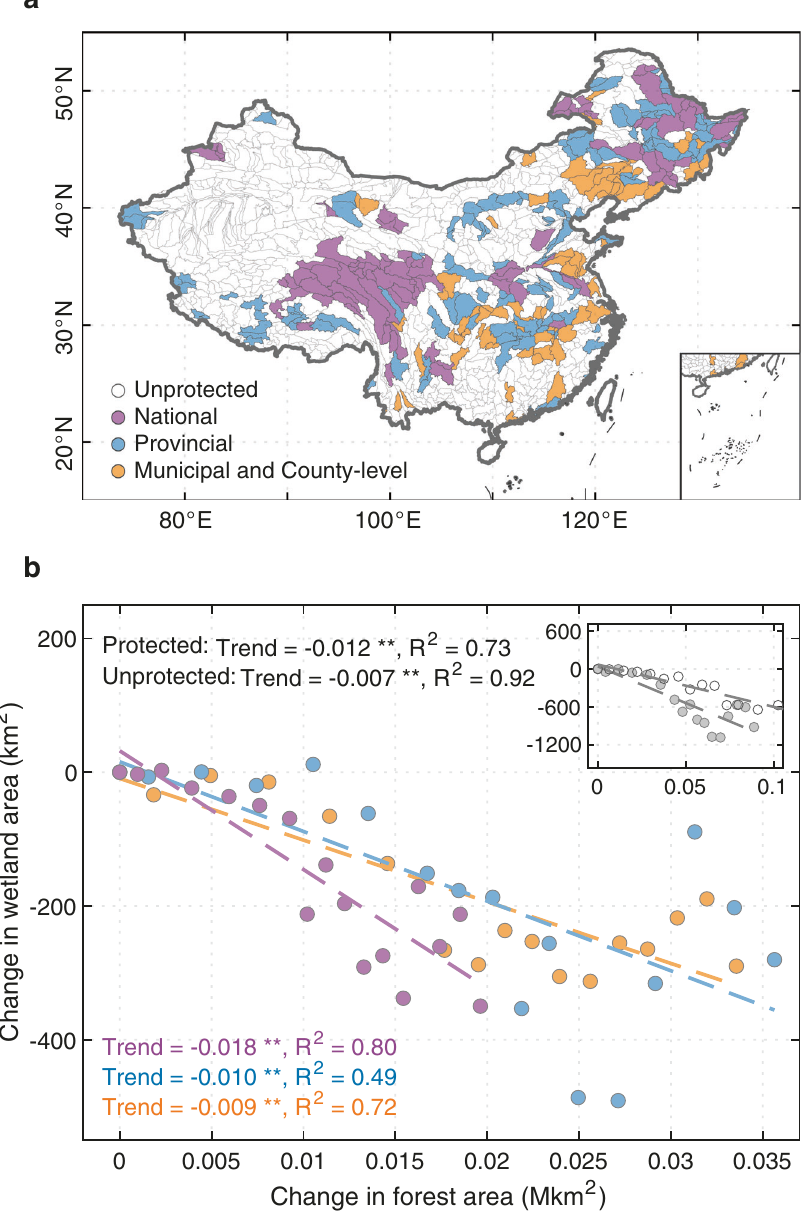
Fig. 4 Historical wetland change due to forest change across protected basins. a Spatial distributions of basins containing unprotected (transparent), national (purple), provincial (blue), and municipal and county-level (orange) wetland nature reserves. b Change in wetland area versus change in forest area across basins with different wetland conservation and all protected and unprotected basins (the inset) from 2000 to 2016. Two asterisks indicate statistical signi fi cance at the 99% con fi dence level. Note that since the forest area is monotonically increasing, the points in Fig. b from left to right correspond to the years from 2000 to